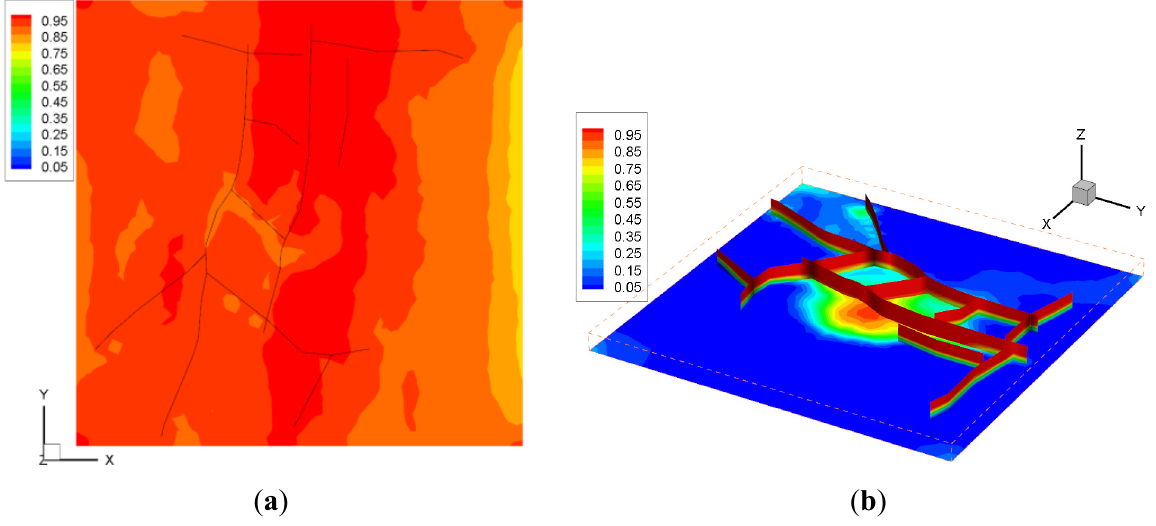
Figure 28. Gas saturation at the top layer ( a ) and bottom layer ( b ) after 30 days’